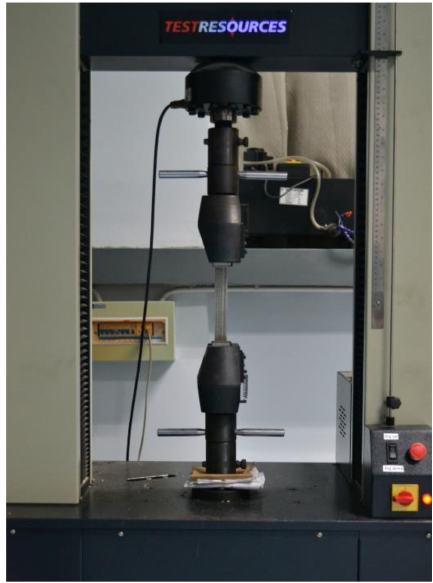
Figure 5. Experimental setup for the uniaxial tensile tests.